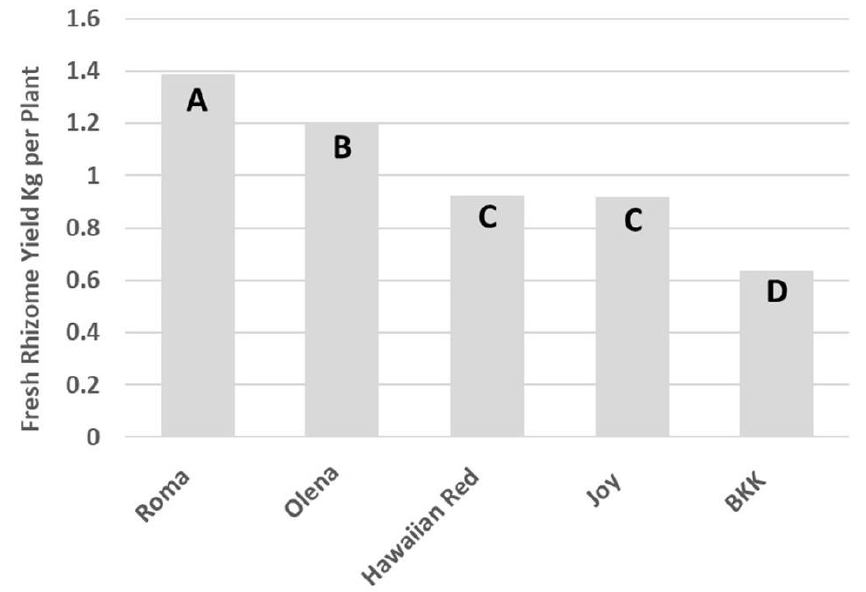
Figure 2. Fresh finger yield of the five reoccurring cultivars across all iterations except Maui Ag. Park 2019. N = 24 (4 replications at each of 6 iterations). Letters indicate means separation by LSD 0.05 . Means with the same letter are not significantly different from each other.